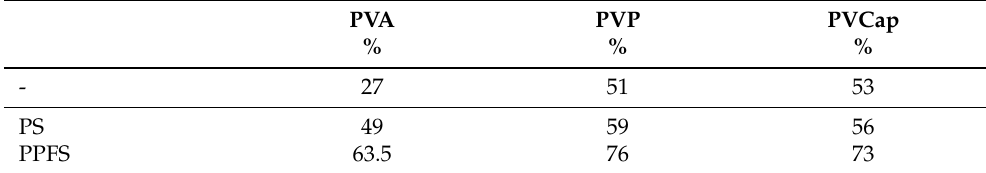
Table 1. Reduction in methane gas mole consumption during hydrate growth phase for hydrophilic polymers PVA, PVP, and PVCap, and amphiphilic block copolymer combinations of PVA, PVP, PVCap with PS and PPFS [41,42].